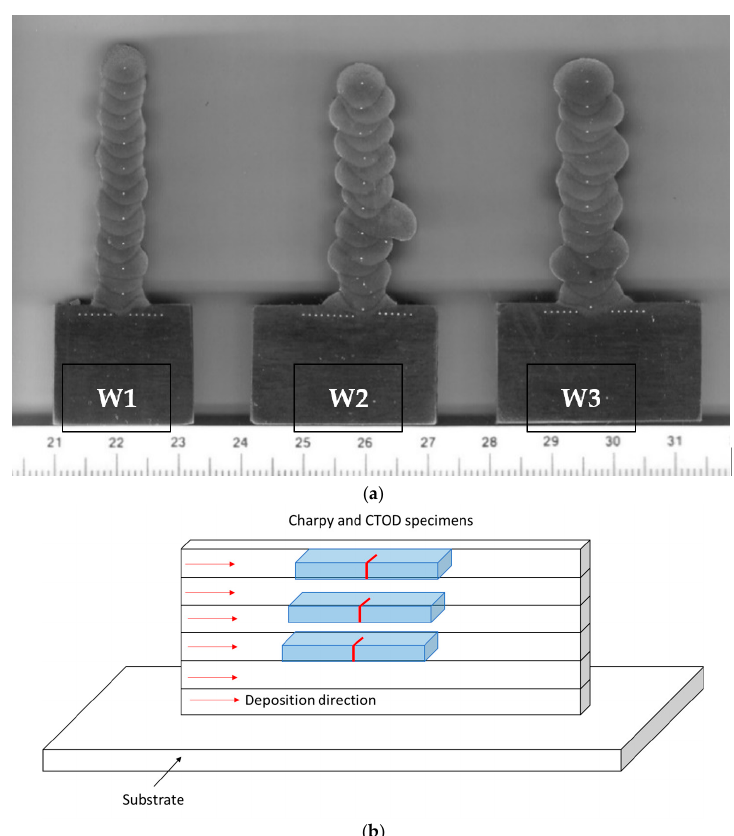
Figure 2. ( a ) Macrographs of walls (cross sections). ( b ) Schematic illustration of the walls with the Charpy and crack tip opening displacement (CTOD) specimens